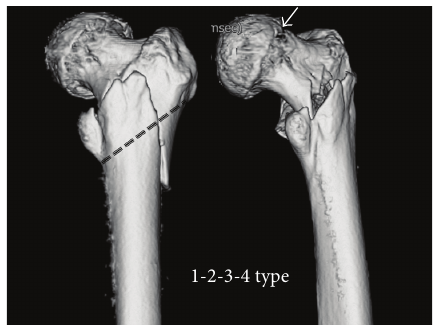
Figure 4: A fracture that penetrates all areas. A fracture is detected (white